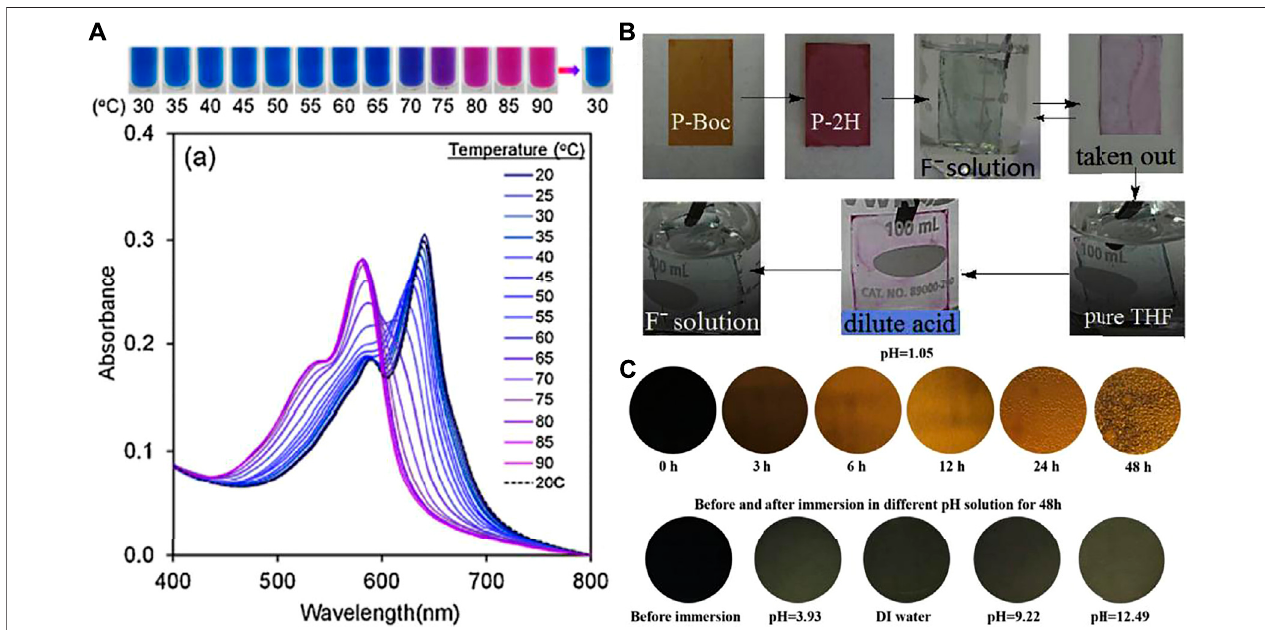
FIGURE2|(A) AbsorptionspectraofPDA(8,9)/PVP10nanocompositesmeasureduponincreasingtemperature. Dashedlinesrepresentspectrameasuredupon the consecutive cooling (photographsof the colour transition are illustrated above the spectra), (B) Photos ofdried P-2H fi lm in THFsolutionof fl uoride anion or HCl with soluteconcentrationof10 – 5 M (C) Colourchangeinthe1,4-BDF-basedepoxycoatingsamplesafterimmersionindifferentpHsolutionsanddigitalimagesofthecoating samples after immersion in the other pH solutions (from pH (cid:1) 3.93 to pH (cid:1)